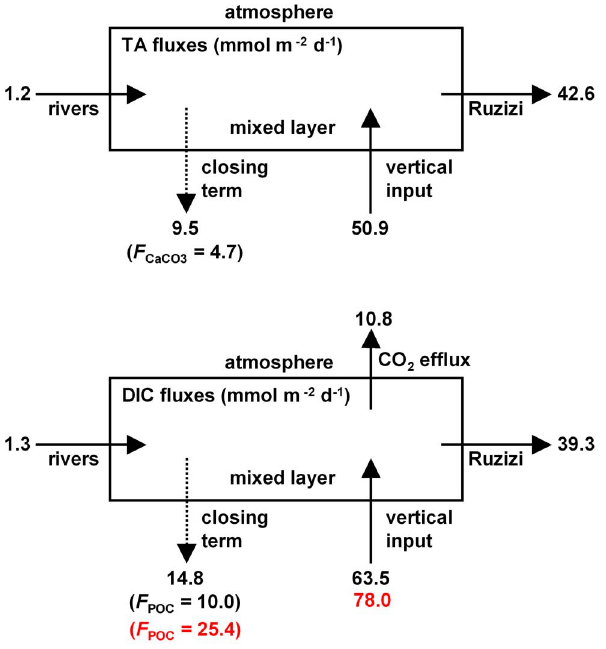
Figure 10. Average mass balance of total alkalinity (TA) and dissolved inorganic carbon (DIC) in the mixed layer of the main basin of Lake Kivu based on data collected in March 2007, September 2007, June 2008 and April 2009. F POC = export of particulate organic carbon to depth; F CaCO3 = export of CaCO 3 to depth. Numbers in black correspond to the mass balance based on bulk concentrations, and numbers in red correspond to the mass balance based on DIC stable isotopes. All fluxes are expressed in mmol m 2 2 d 2 1 .